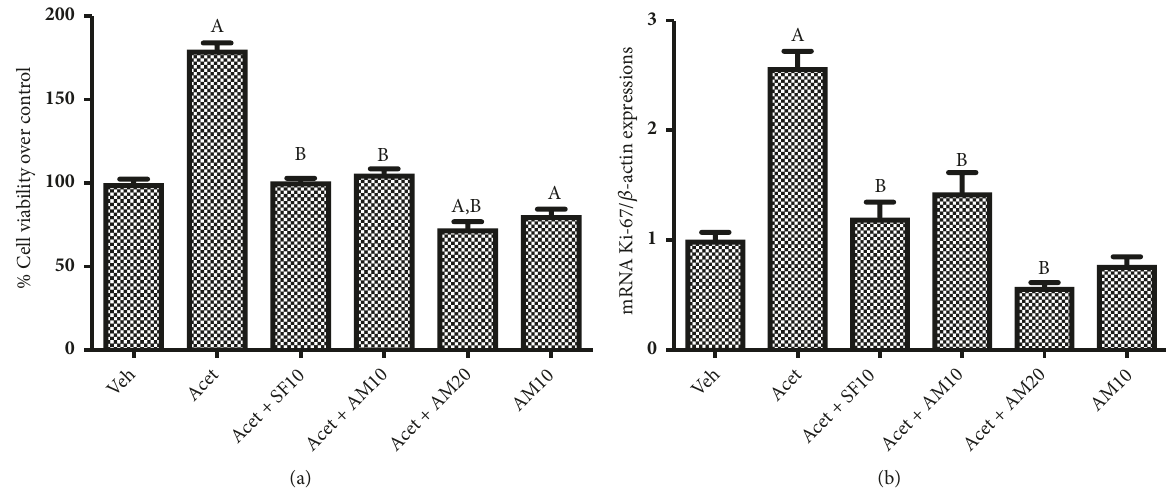
Figure 3: Effect of alpha mangostin in HSC proliferation as shown by (a) percentage of cell viability over control. (b) mRNA expressions of Ki67/ 𝛽 -actin expressions, after LX-2 cells were treated with alpha mangostin with or without acetaldehyde induction. Results were presented as mean ± SEM. A: p < 0.05 versus untreated group, B: p < 0.05 versus acetaldehyde group. Veh: vehicle only, Acet: acetaldehyde 100 𝜇 M, Acet+ SF10: acetaldehyde 100 𝜇 M + sorafenib 10 𝜇 M, Acet + AM10: acetaldehyde 100 𝜇 M + alpha mangostin 10 𝜇 M, Acet + AM20: acetaldehyde